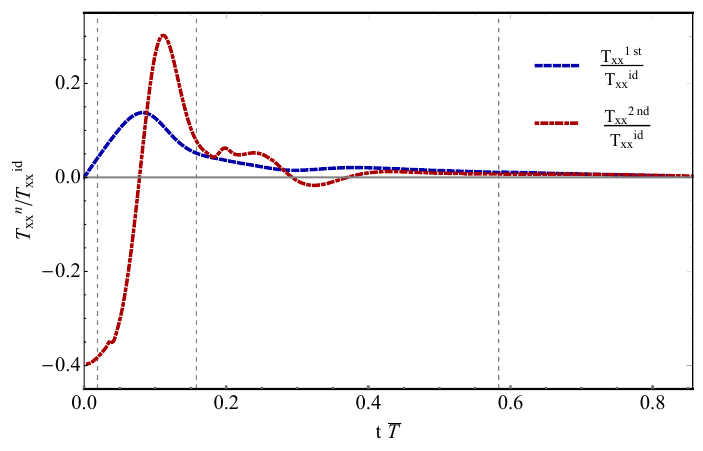
Figure 2 . Ratios T n /T ideal , n = 1 , 2 , of the constitutive relations (2.3) evaluated at { x, y } T ’ xx xx { 0 . 12 , 0 } as a function of time for the holographic solution. The vertical dashed lines show the times at which we initialize the hydrodynamics codes tT ’ 0 . 019 , 0 . 16 , 0 . 58